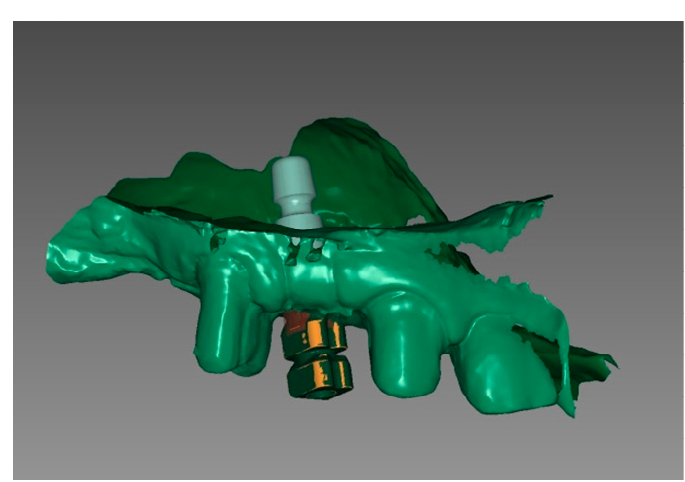
Figure 11. Chairside digital impression in region 14, exocad, SW 3.0 Galway.